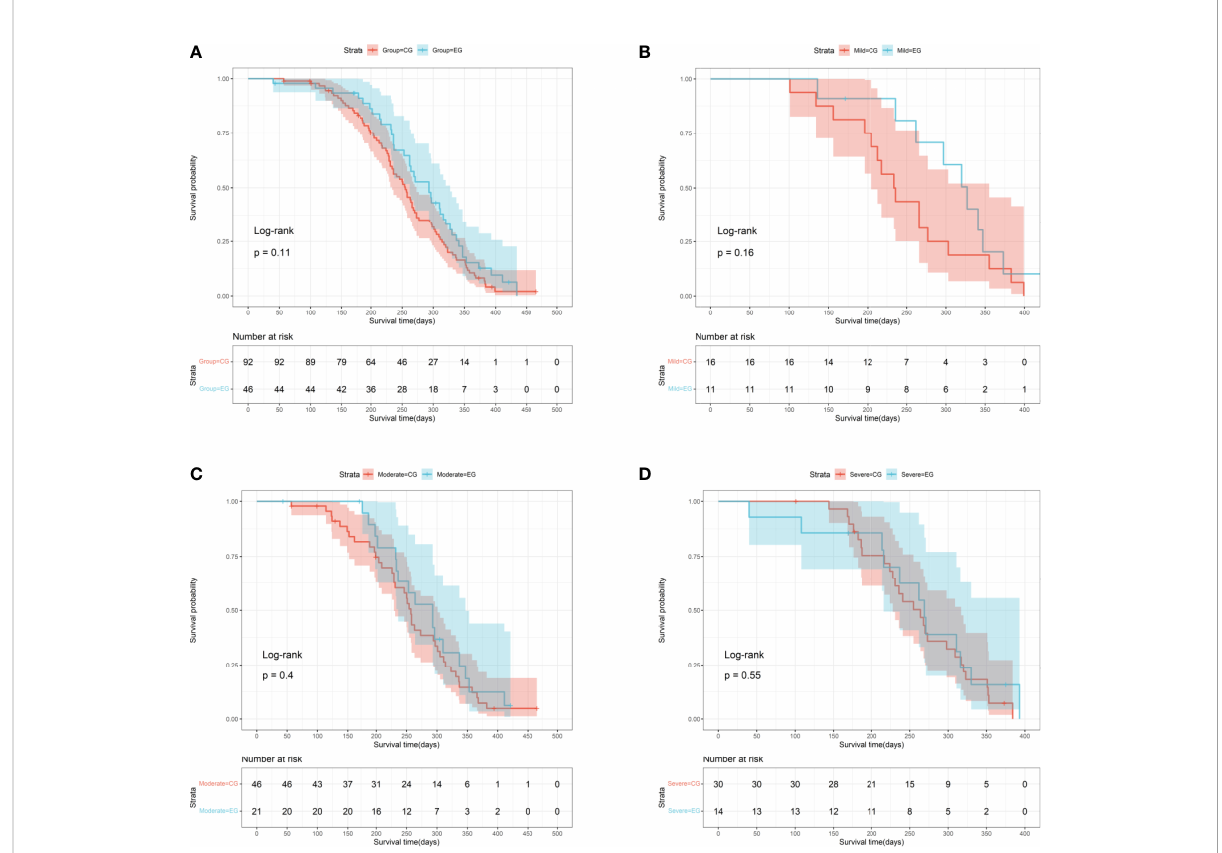
FIGURE 4 Survival curves for MESCC patients strati fi ed by the presence of preoperative embolization. (A) The entire cohort (P=0.11, log-rank test); (B) Patients with mild hypervascularity (P=0.16, log-rank test); (C) Patients with moderate hypervascularity (P=0.40, log-rank test); (D) Patients with severe hypervascularity (P=0.55, log-rank test). EG indicates the embolization group; CG indicating the control